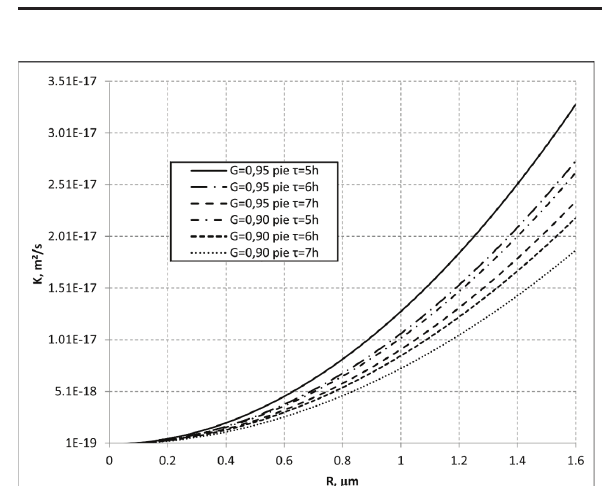
Figure 1: Simulation output showing the dependence of K on input parameters G, R and